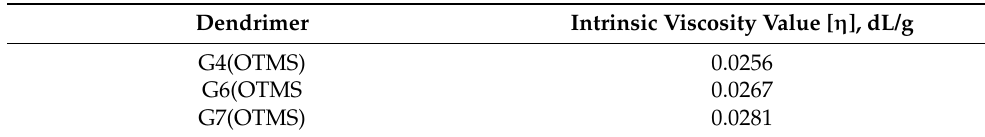
Table 2. Intrinsic viscosity of the hybrid carbosilane-siloxane